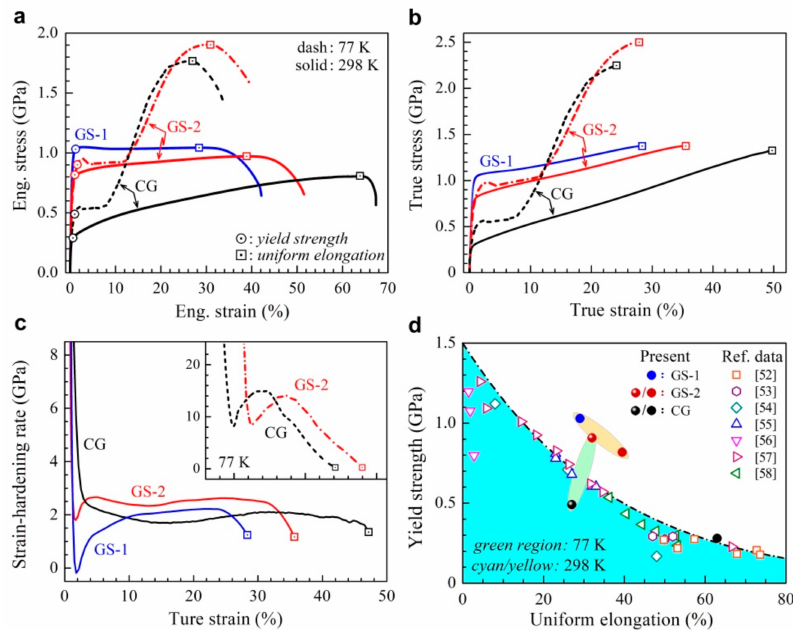
Figure 3. The tensile properties of CG, GS1 and GS2 samples at both room and cryogenic tempera- tures. ( a ) The engineering stress–strain curve. ( b ) The true stress–strain curves. ( c ) The hardening rate–true strain curves. ( d ) The yield strength as a function of the uniform elongation for our results, along with the data from previous research for 304 ss